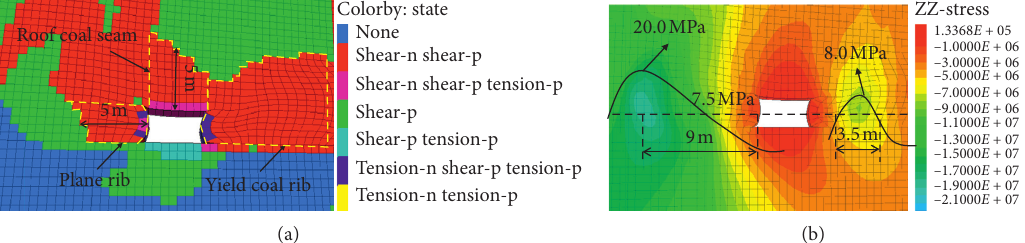
Figure 4: Stress and plastic zone distribution developed around the gob-side entry in section 8211: (a) plastic zone; (b) vertical